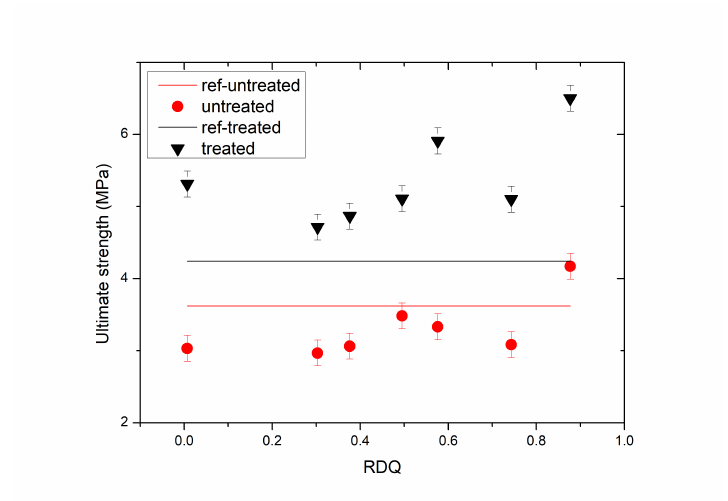
Figure 5. A development of ultimate strength of CNT/NBR nanocomposites as a function of relative dispersion quality. Dashed lines are representing unfilled NBR elastomer